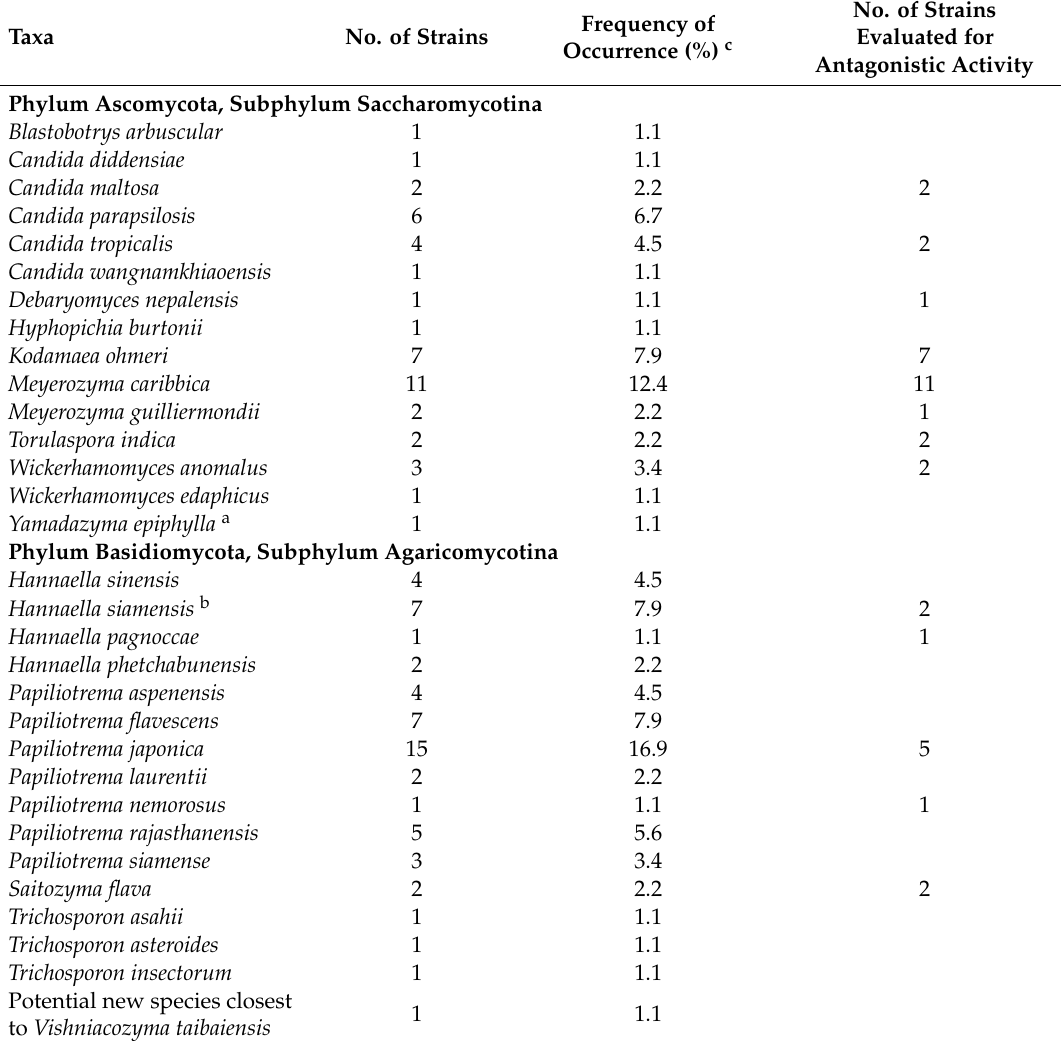
Table3. YeastspeciesandstrainsbelongingtothephylaAscomycotaandBasidiomycotainricephylloplane. Taxa No. of Strains